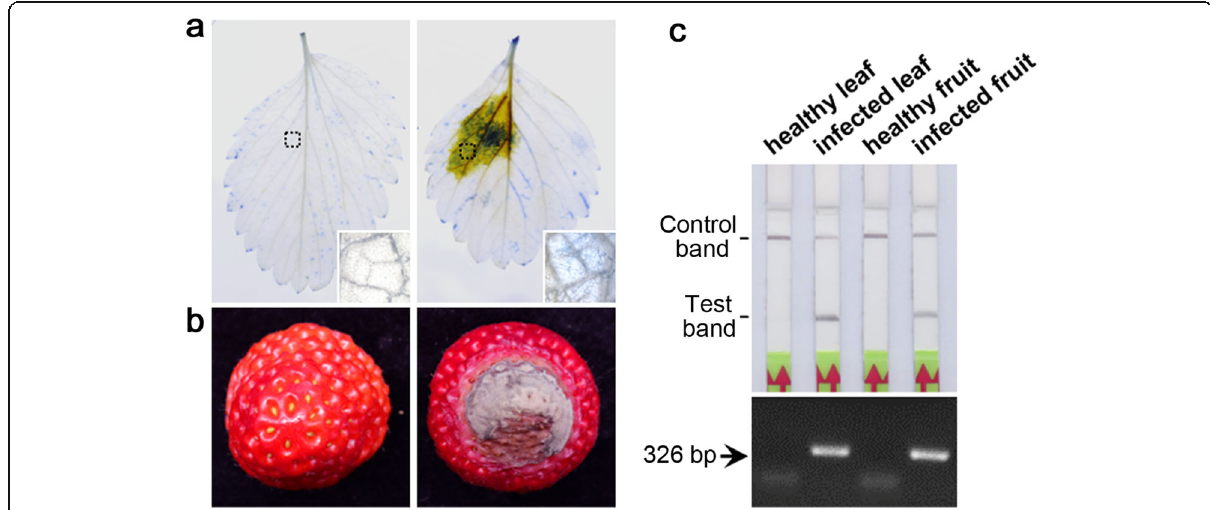
Fig. 4 Evaluation of LF-RPA detection of P. cactorum in infected plant tissues. a P. cactorum -inoculated leaves at 5 days post-inoculation (dpi). Mycelia were visualized using trypan blue staining. b Representative disease symptoms of Phytophthora fruit rot in strawberry caused by P. cactorum . c LF-RPA and conventional PCR assays of genomic DNA extracted from healthy and infected strawberry